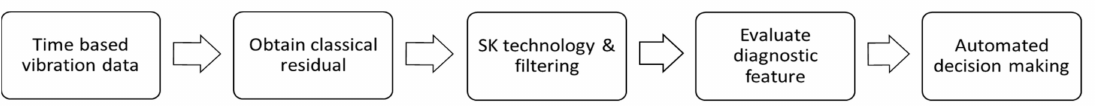
Figure 7. Flowchart of diagnosis methodology.